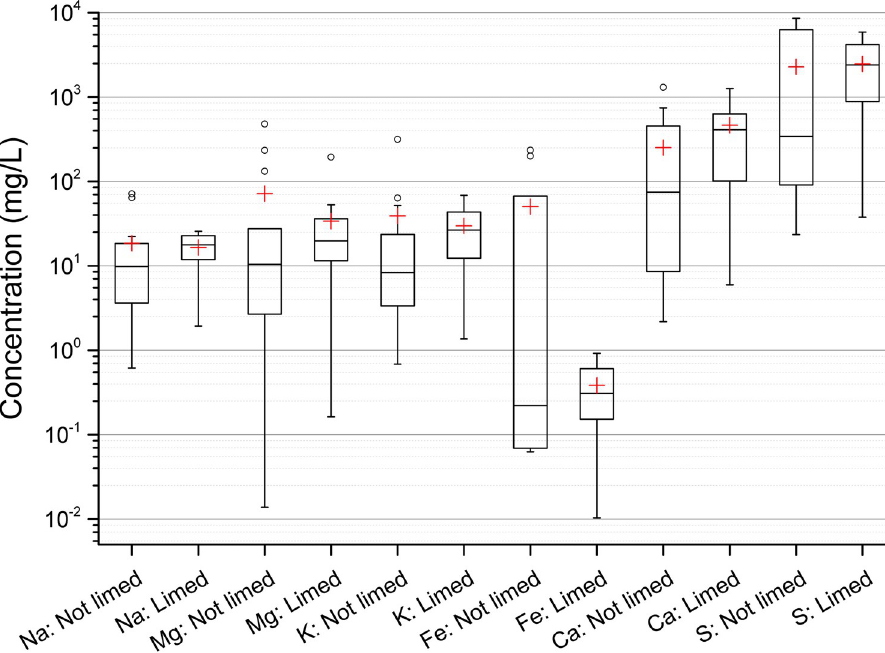
Fig 3. Comparison of the concentration of Na, Mg, K, Fe, Ca and S in surface water between limed and non-limed pit lakes. The height of the box shows the interquartile range, which contains 50% of the values, the horizontal line inside the box shows the median value and the red cross denotes the mean value. The whiskers are lines that extend from the box to the highest and lowest values excluding outliers (o). Outliers represent those data with values being 1.5 higher or lower than the height of the box. Detailed data are given in supplementary data